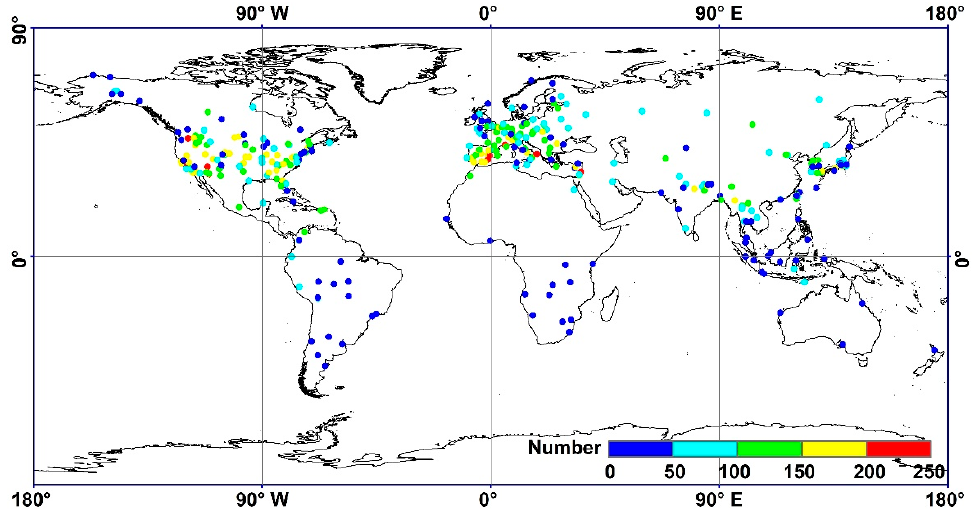
Figure 2. Spatial distribution of AERONET sites used for validation of four MERSI-2 PWV products. Each dot represents an AERONET site. The color of these dots indicates the number of matching results between AERONET data and each MERSI-2 PWV product.